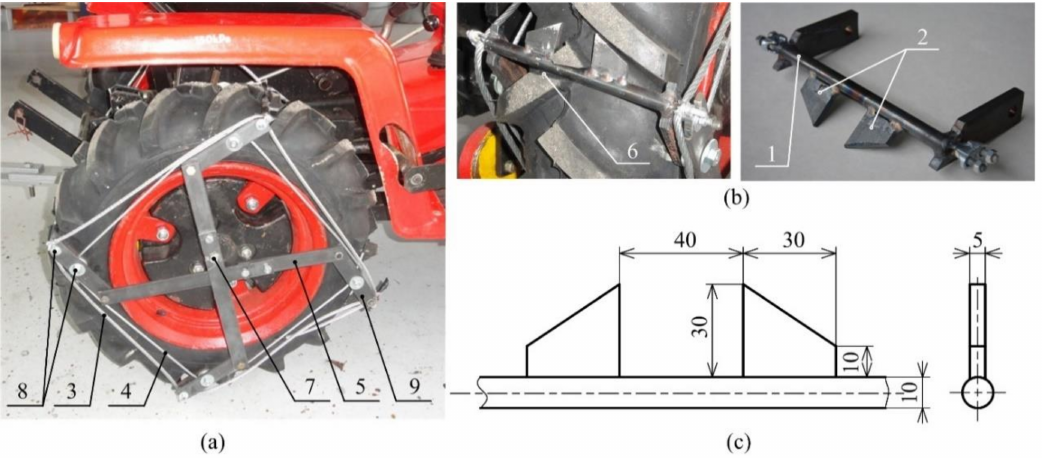
Figure 2. Spike tires: ( a ) spike tire on the tractor; ( b ) spike element; ( c ) dimensions of spikes: 1—support rod of the spike segment, 2—spike, 3—carrier wire strand, 4—control wire strand, 5—control mechanism, 6—groove in the tire, 7—safety screw, 8—pins, 9—spike element.